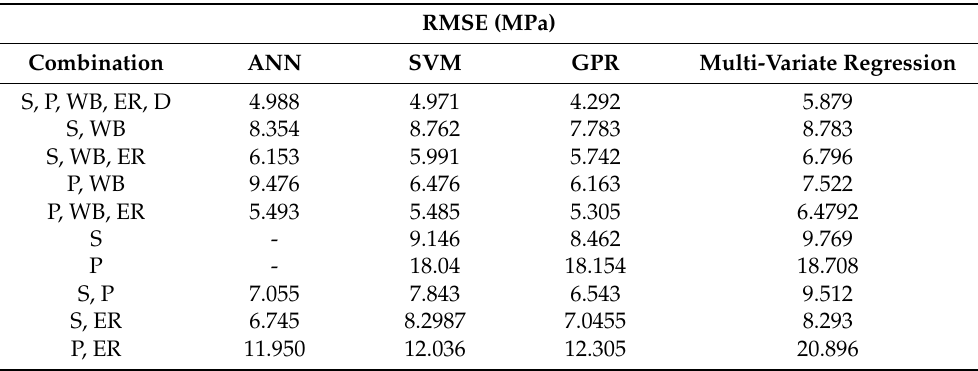
Table 11. Comparison of RMSE between the different methods used in the